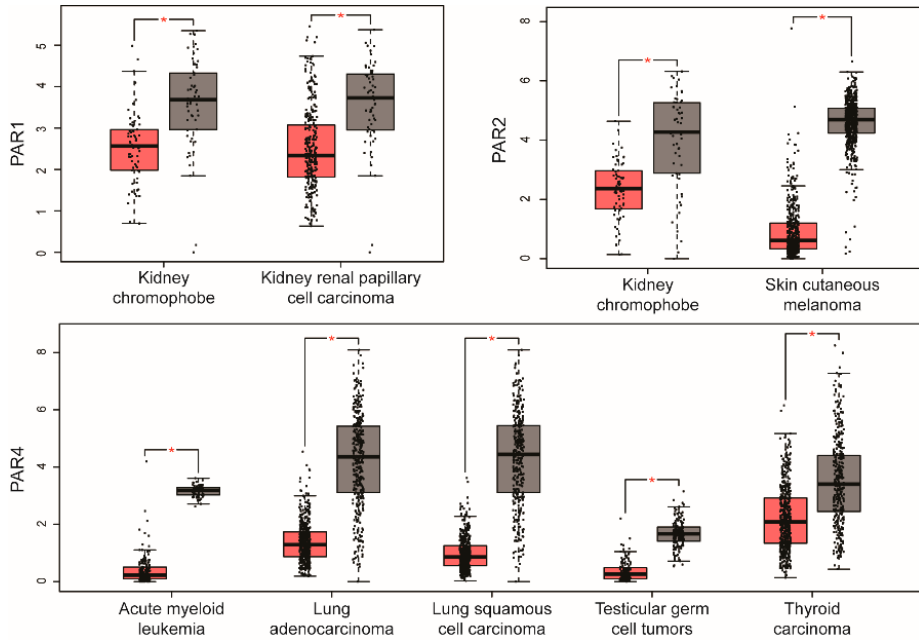
Figure 3. Human cancers with downregulation of PAR1, PAR2 and PAR4 expression. A few cancers displayed significant decreases in expression of PARs based on GEPIA analysis. PAR1 showed significantly downregulation in kidney chromophobe (66 tumor, 53 normal) and kidney renal papillary cell carcinoma (286 tumor, 60 normal). PAR2 was significantly downregulated in kidney chromophobe and skin cutaneous melanoma (461 tumor, 558 normal). PAR4 was significantly downregulated in acute myeloid leukemia (173 tumor, 70 normal), lung adenocarcinoma (483 tumor, 347 normal), lung squamous cell carcinoma (486 tumor, 338 normal), testicular germ cell tumors (137 tumor, 165 normal), and thyroid carcinoma (512 tumor, 337 normal). RNA-seq data are expressed as relative gene expression using transformed log 2 (TPM+1) value ( Y -axis) of tumor (red) and normal (grey) samples from different cancer types and displayed as whisker plots as shown in Figure 1. The data showing differences in